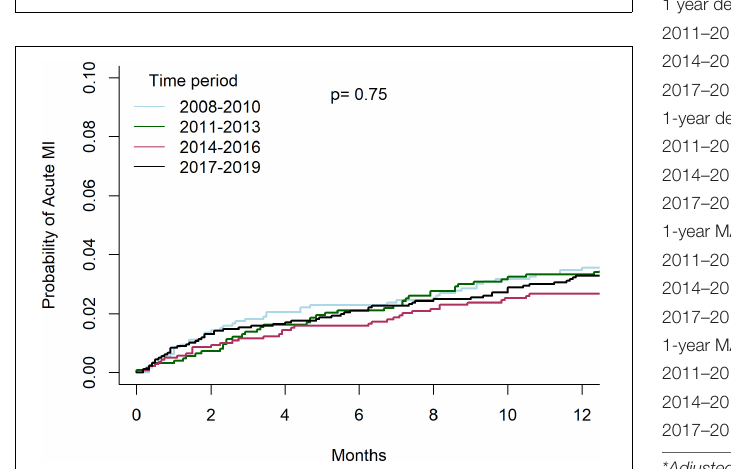
FIGURE 7 | Cumulative incidence of TVR at 1 year, grouped by time period.